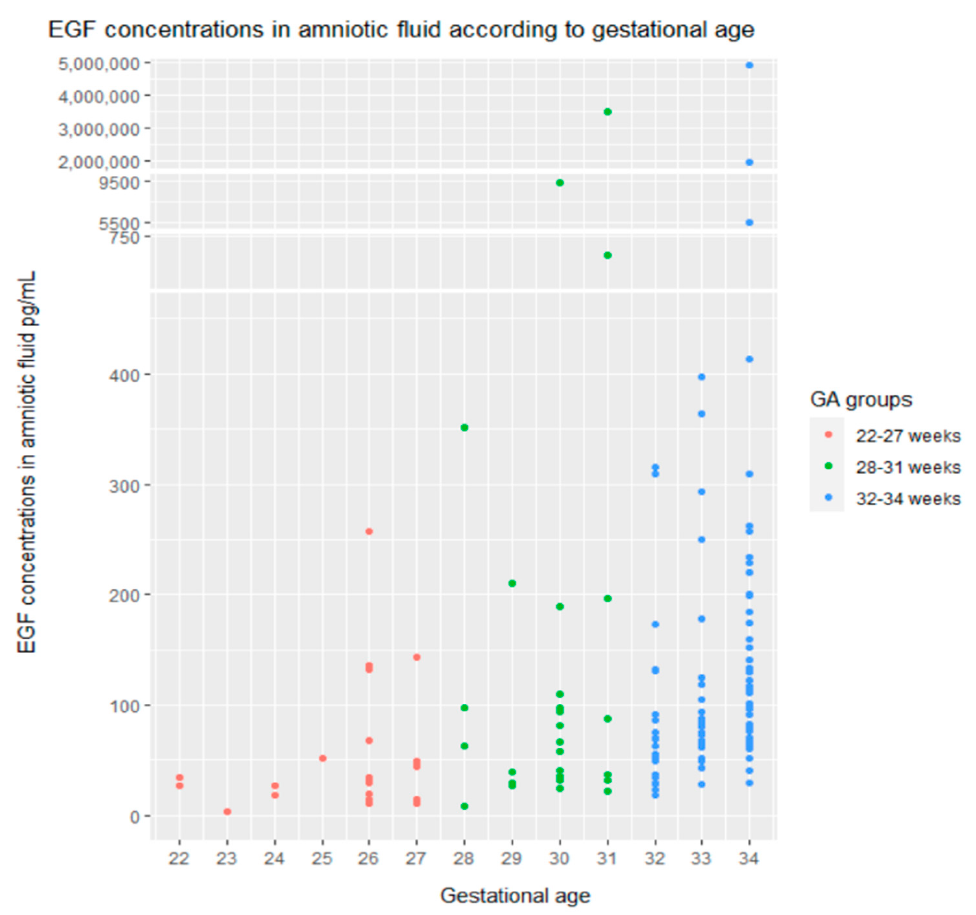
Figure 1. EGF concentrations in the amniotic fluid according to gestational age. Y –axis is displayed with breaks to include all values of EGF, even outliers, using the ggbreak R package [33]. Spearman’s correlation analysis was conducted to assess the association of EGF and other numerical variables. A positive correlation was found between EGF, gestational age, and birth weight. A negative correlation was detected between EGF and the duration of respiratory support (RS), the duration of mechanical ventilation, and the duration of non- invasive respiratory support. However, linear correlations were weak, with Rho coeffi- cients less than 0.5.